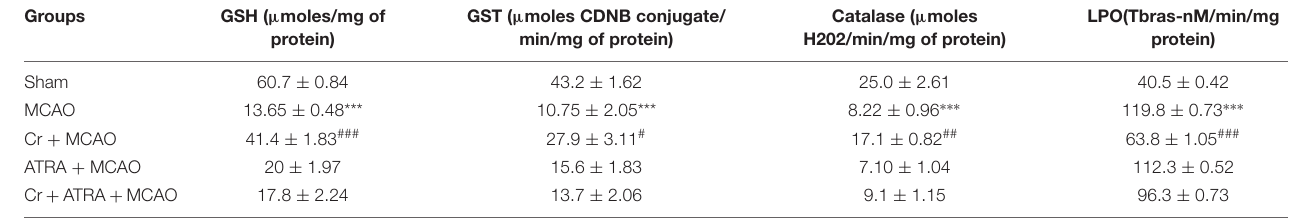
Carveol significantly normalized the cortex antioxidant enzyme levels. Symbols *** shows significant difference p < 0.001 while symbol ## represents p < 0.01 values for significant difference. All data were presented as means ± SEM and analyzed by one-way ANOVA followed by post hoc Bonferroni multiple comparison test. Symbols * show a significant difference of MCAO relative to sham and # shows a significant difference of MCAO (n = 5/group). After euthanasia, samples were collected and preserved at − 80 ◦ C. Abbreviations: GST, glutathione S-transferase; GSH, glutathione; TBARS, thiobarbituric acid reactive substances; LPO, lipid peroxidation. ### Indicates p < 0.001 and it shows significant difference relative to